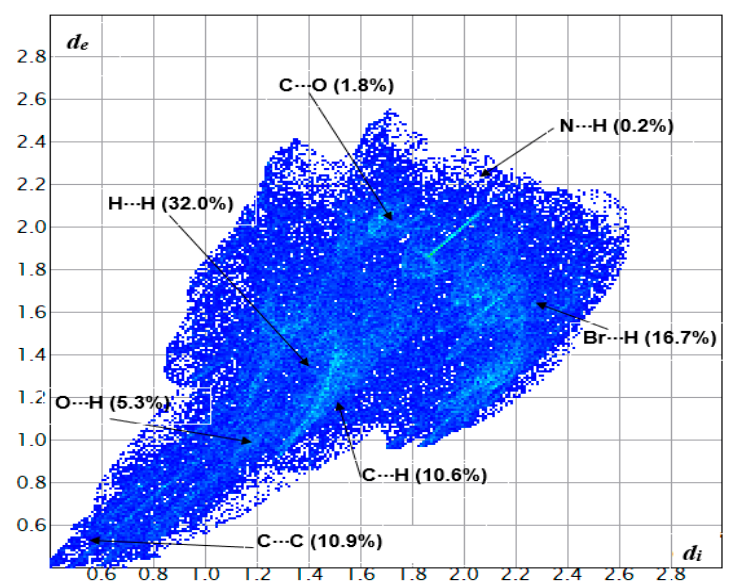
Figure 8. Two-dimensional fingerprint plots showing the highest interactions of 2a . d i corresponds to the closest internal distance from a given point of the HF surface, and d e to the closest external contacts (i.e., external distance).